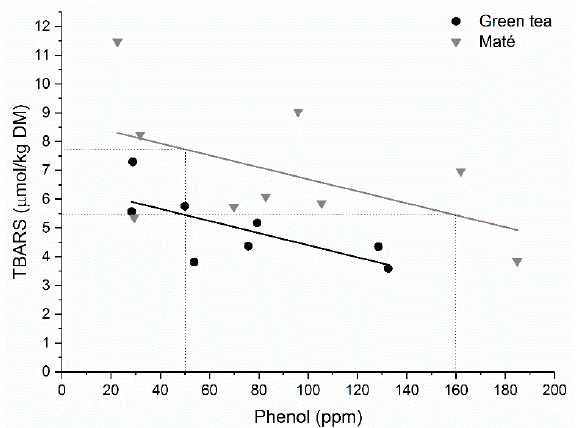
Figure 3. TBARS plotted as a function of phenolic content for all samples containing green tea or maté extract. Linear fit for samples added green tea extract ( ● ): y = − 0.0210x ∙ 6.50, R 2 = 0.488, and for samples added maté extract ( ▼ ): y = − 0.0208x ∙ 8.77, R 2 = 0.272. Dashed lines indicate the concentration of phenol needed to obtain comparable TBARS levels.